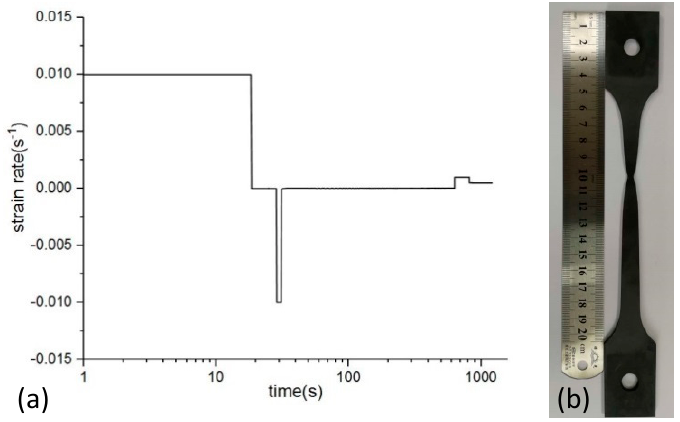
Figure 7. Complex loading tensile test of Inconel 718. ( a ) Strain rate loading curve; ( b ) Tensile specimen.